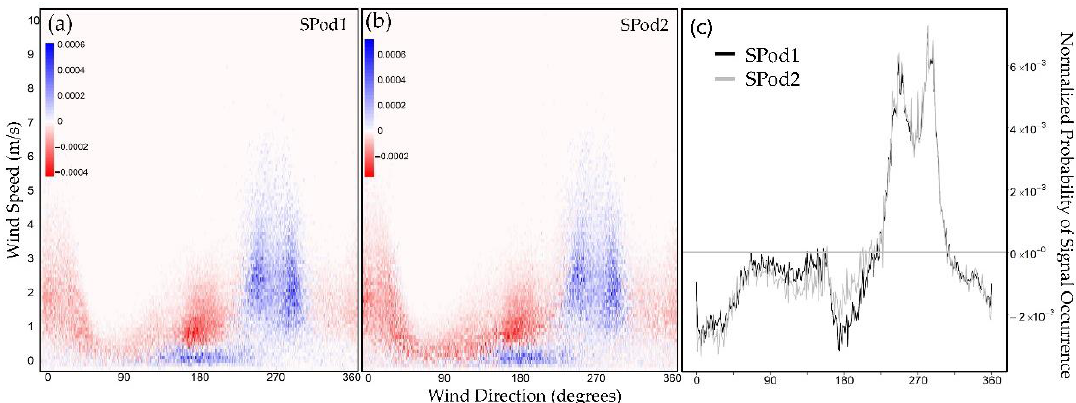
Figure 8. Individually normalized above TDL DC matrix minus all signal DC matrix for: ( a ) SPod1; ( b ) SPod2; ( c ) wind speed aggregated version of the angle resolved relative detection signal for both SPods.